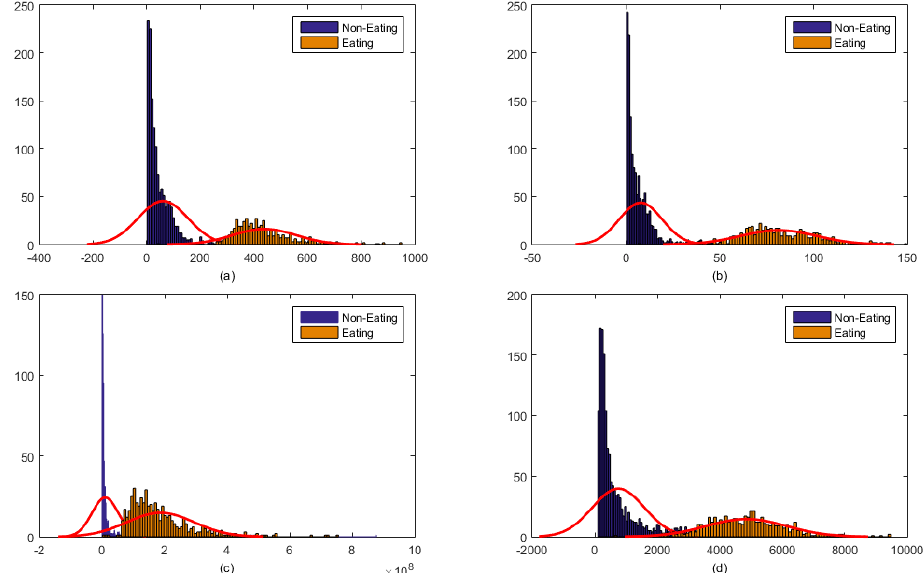
Figure 3. Histogram showing the distribution of piezoelectric strain sensor signal features: ( a ) Range of values ( b ) Standard deviation ( c ) Energy ( d ) Waveform length. The feature distribution shows that these features can easily provide information for separation of food intake from non-intake.